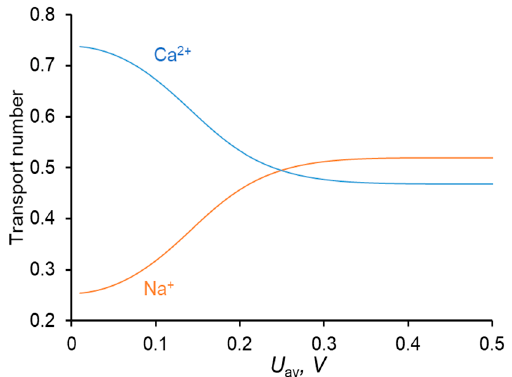
Figure 3. Dependence of the transport numbers of Ca 2+ and Na + ions in the membrane on the time–average voltage.